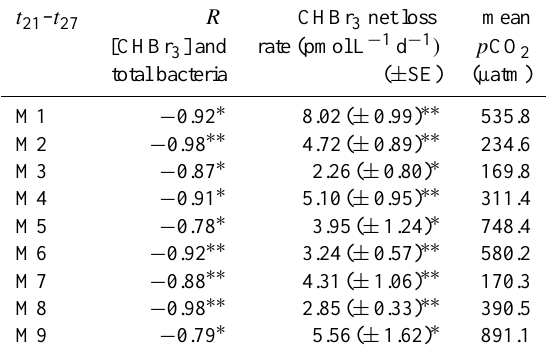
Table 6. Correlation coefficients ( R) for relationship between CHBr 3 and total bacteria, CHBr 3 net loss rates, and mean p CO 2 for period t 21 – t 27 . Asterisks indicate associated probability of rates, ∗ = p < 0.05, ∗∗ = p < 0.01. t 21 – t